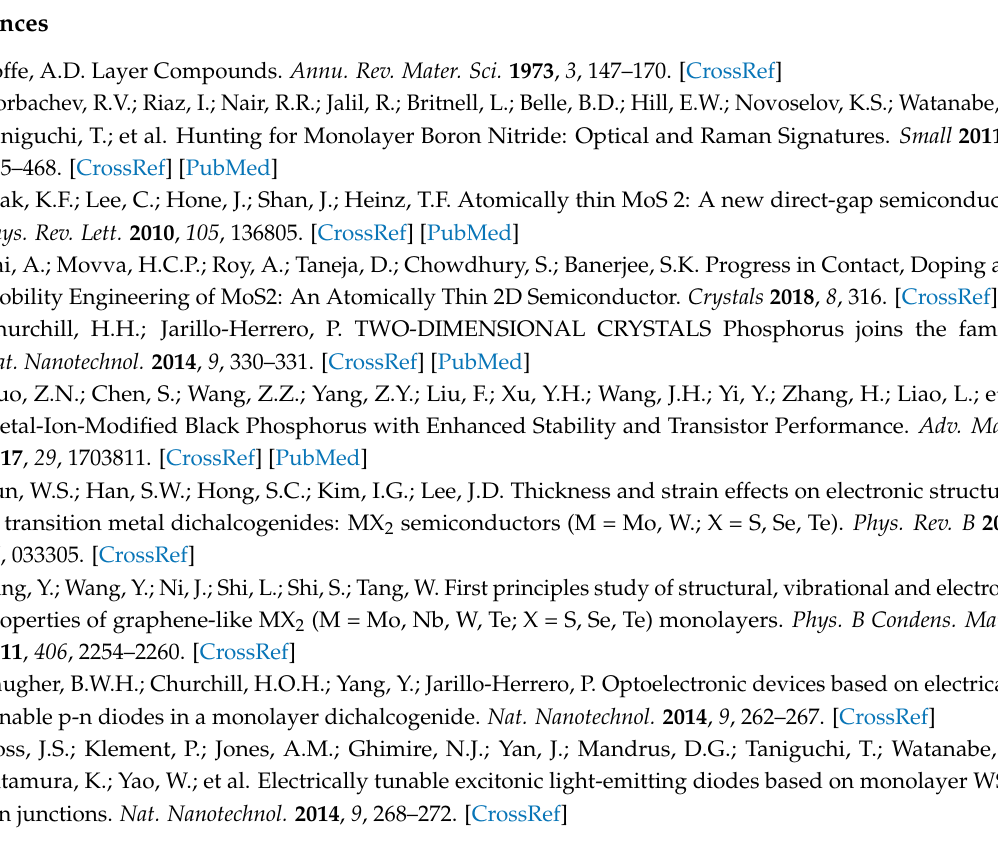
Figure S1: Electronic band structures of β -InSe monolayer (1 L), few-layer (2 L to 9 L) and bulk β -InSe extracted from GGA-PBE functional calculations, Figure S2a: Calculated total density of states (TDOS) and partial density of states (PDOS) of β -InSe monolayer (1 L) and few layer (2 L to 9 L) and bulk β -InSe based on GGA-PBE functional, Figure S2b: Calculated partial density of states (PDOS) of β -InSe monolayer (1 L) and few layer (2 L and 3 L) and bulk β -InSe, Figure S3: GGA-PBE band gap energies of few-layer of β -InSe as a function of number of layer, Table S3: Tabulation of work function values of β -InSe monolayer (1 L), few-layer (2 L to 9 L) and bulk β -InSe, Figure S4: (a) Calculated phonon band dispersion structure of β -InSe a long high-symmetry direction Г -Z-M-A- Г (b) Total potential energy fluctuation of β -InSe monolayer from 500 to 4000 fs during AIMD simulations at the temperature of 300 K, Figure S5: Calculated real part of the dielectric function a long x and z direction for β -InSe monolayer (1 L), few-layer (2 L to 9 L) and bulk β -InSe, Figure S6: Calculated imaginary part of the dielectric function a long x and z directions for β -InSe monolayer (1 L), few-layer (2 L to 9 L) and bulk β -InSe, Figure S7: Calculated refractive index (n) a long x and z directions for β -InSe monolayer (1 L), few-layer (5 L) and bulk β -InSe, Table S1: Tabulation of band gap energy values extracted from different functionals calculations of β -InSe monolayer (1 L), few-layer (3 L and 5 L) and bulk β -InSe, Table S2: Tabulation of band gap energy values extracted from DFT calculations of β -InSe monolayer (1 L), few-layer (2 L to 9 L) and bulk β -InSe based on